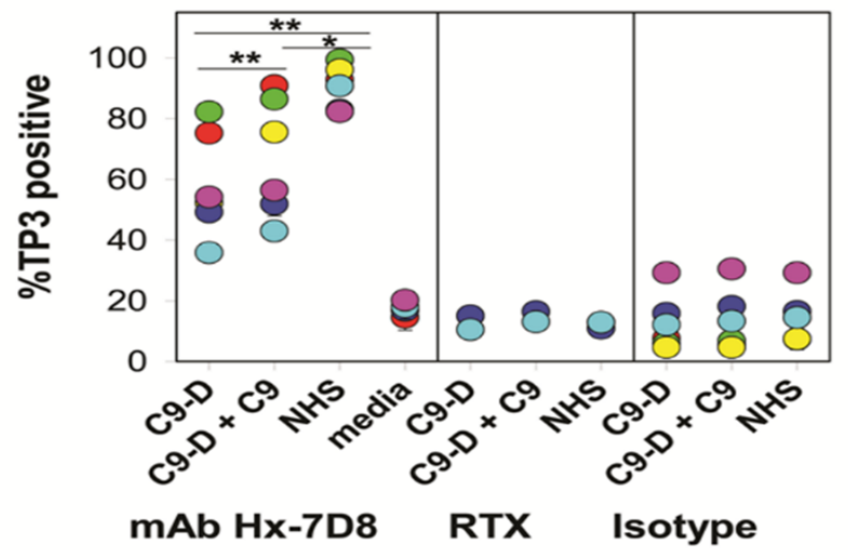
Figure 14. C9-deficient serum can mediate high levels of CDC of CLL cells opsonized with mAb Hx-7D8. C9-deficient (C9-D) serum lacks any detectable C9, but can mediate high levels of lysis of CLL cells reacted with mAb Hx-7D8. The ability of mAb Hx-7D8 to promote CDC in CLL cells from six di ff erent patients was evaluated in either: C9-D serum (25%), C9-D serum (25%) supplemented with 18 µ g / mL C9, or NHS (25%). Controls included Hx-7D8 reacted with cells in media (4 of 6 CLL cell samples) as well as cells reacted with RTX (2 CLL samples) or an isotype control (Isotype, Hx-b12, 2–4 CLL samples) reacted with CLL cells in all three conditions. Each color represents a di ff erent patient (pn); all determinations were in duplicate or triplicate and means and SD are provided. Mean % CDC and SD: 58 ± 17% for CLL cells reacted in C9-D serum; 67 ± 20% for CLL cells reacted in C9-D serum + C9; 91 ± 7% for CLL cells reacted in NHS. * p < 0.05; ** p < 0.01 [21] . Figure 15. Analysis of CDC and Ca 2 + fluxes in Fluo-4-loaded CLL cells. ( A ) CDC kinetics mediated by Hx-7D8 in C9-D serum (pn 2014, red circles, Figure 14) were slower and killing peaked at approximately 80%, compared to results in intact NHS where killing reached 95%. CDC mediated by RTX was low under both conditions. ( B ) During CDC mediated by Hx-7D8 (also pn 2014), the Fluo-4 signal is increased considerably and remains substantially elevated for 3 min (indicative of the transition-state intermediate) for CLL cells reacted with Hx-7D8 in C9-D serum. Controls include cells reacted for 900 s in NHS or in C9-D serum, with either the isotype control Hx-b12, or with no mAb. Figures 14 and 15 are reprinted from Clinical Immunology, Vol. 181, 2017, Taylor, R.P. et al. Hexamerization-enhanced CD20 antibody mediates complement-dependent cytotoxicity in serum genetically deficient in C9, pp. 24–28, with permission from Elsevier. [21] .